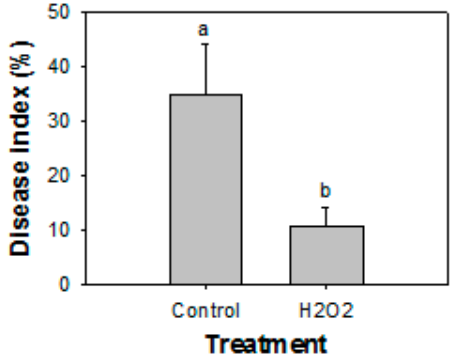
Figure 6. Effect of treatment with 20 mM H 2 O 2 on the development of natural decay in intact papaya fruit. The data were expressed as the means ± SE of three biological replicates. Different letters in ‐ dicate significant differences.